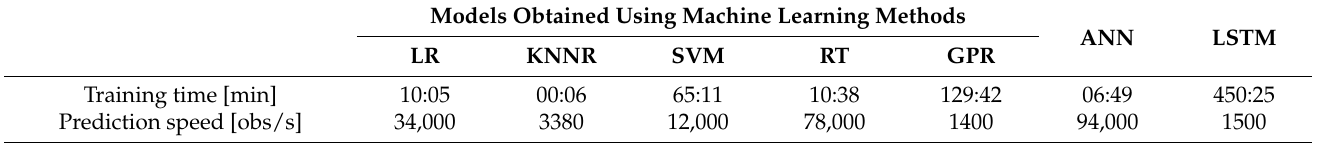
Table 8. Training time and prediction speed for all analyzed models.